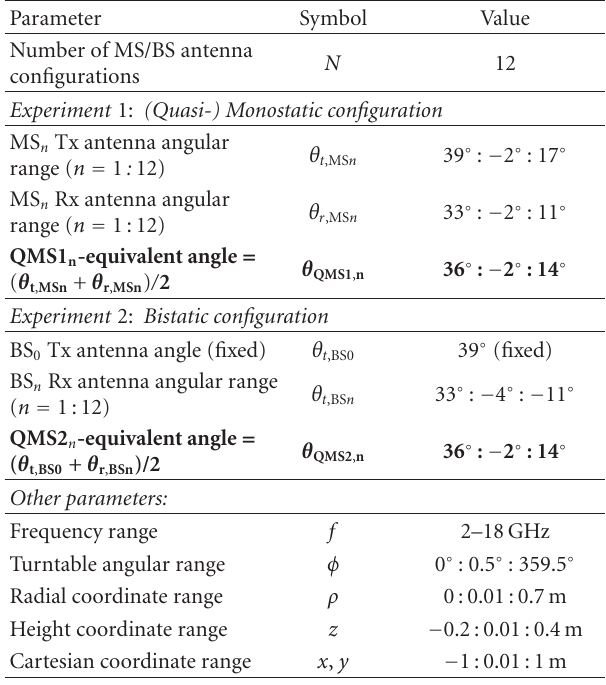
Table 1: Parameters for simulated and experimental SWISAR